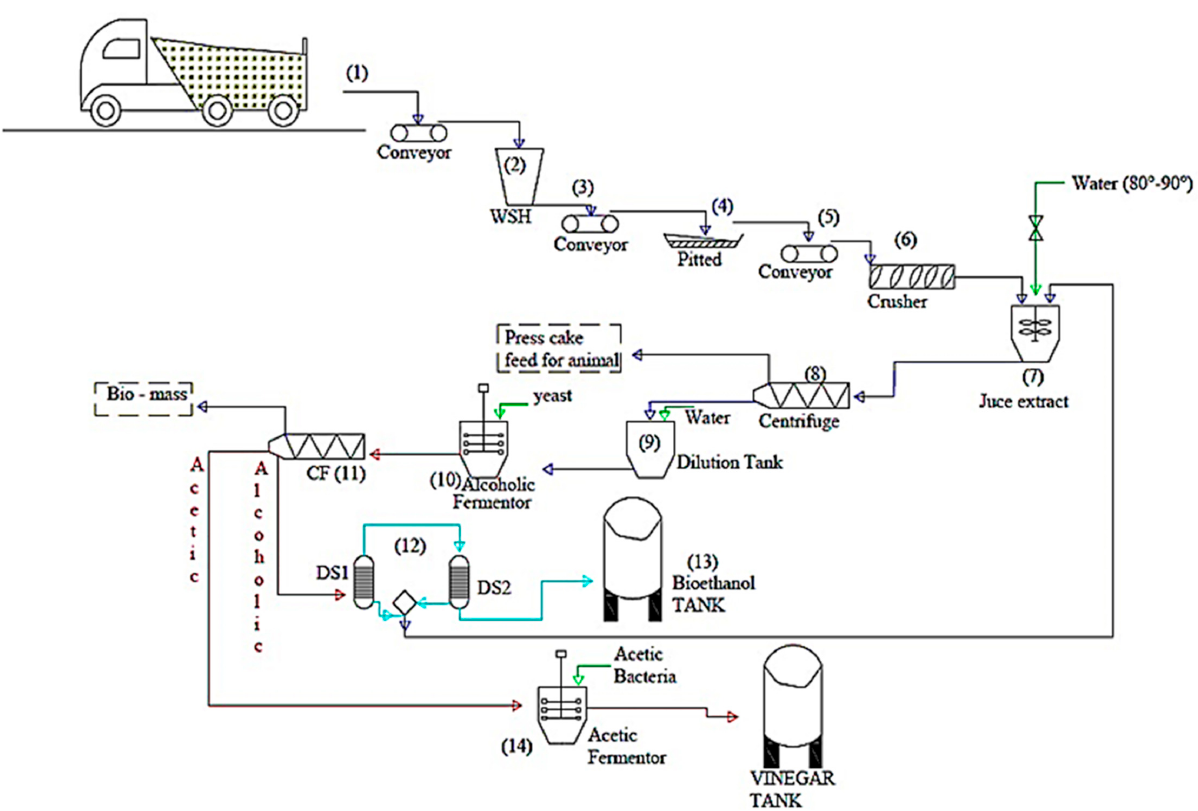
Figure 8. Detailed flow diagram of bioethanol and vinegar production process from waste dates.